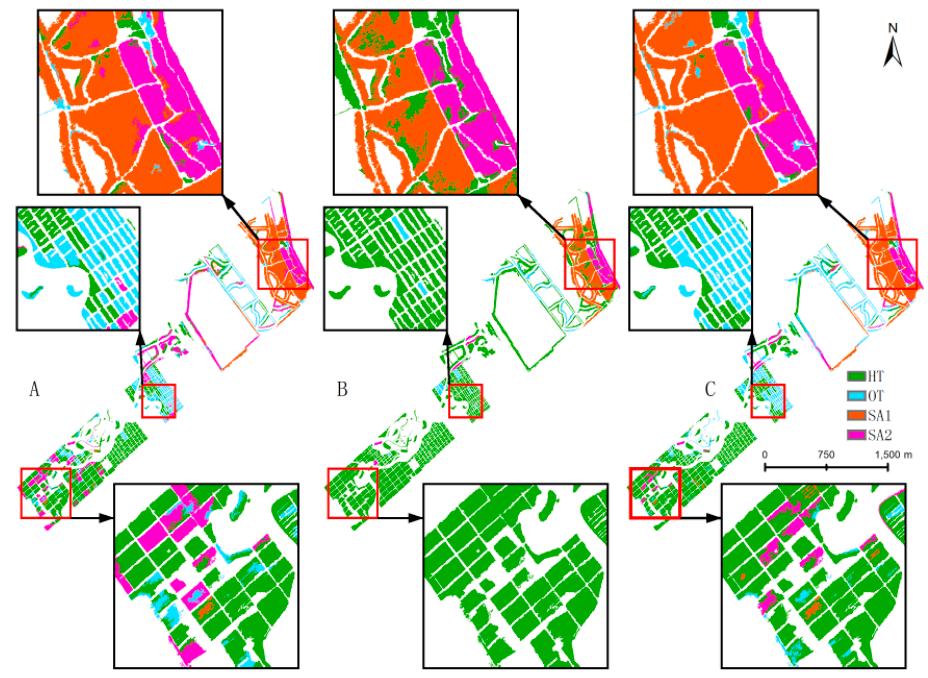
Figure 5. Comparison of object-based classification: ( A ) decision tree-based classification; ( B ) support vector machine-based classification; and ( C ) random forest-based classification.